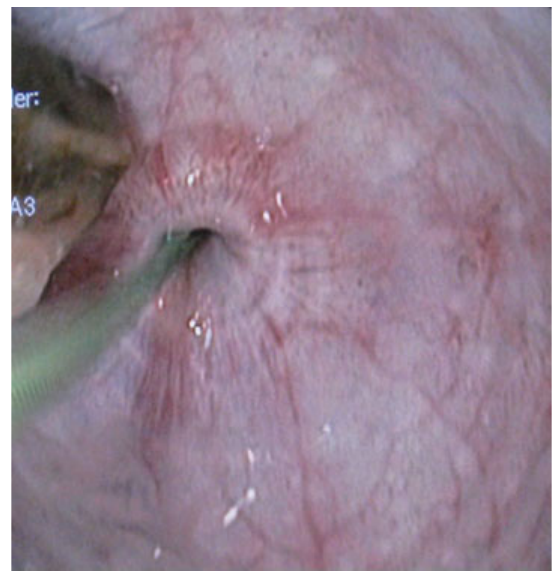
Fig. 1 Through the videoendoscope the rectourethral fi stula is easily identi fi ed and a guidewire is passed through the videoendoscope and through the rectourethral fi stula.